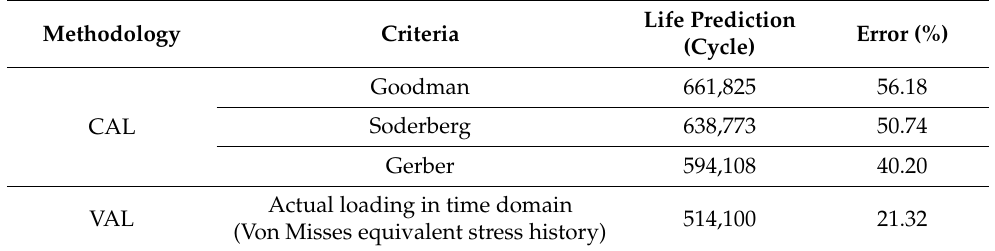
Table 5. Comparison of fatigue life prediction by utilizing different methodologies and experiment results.